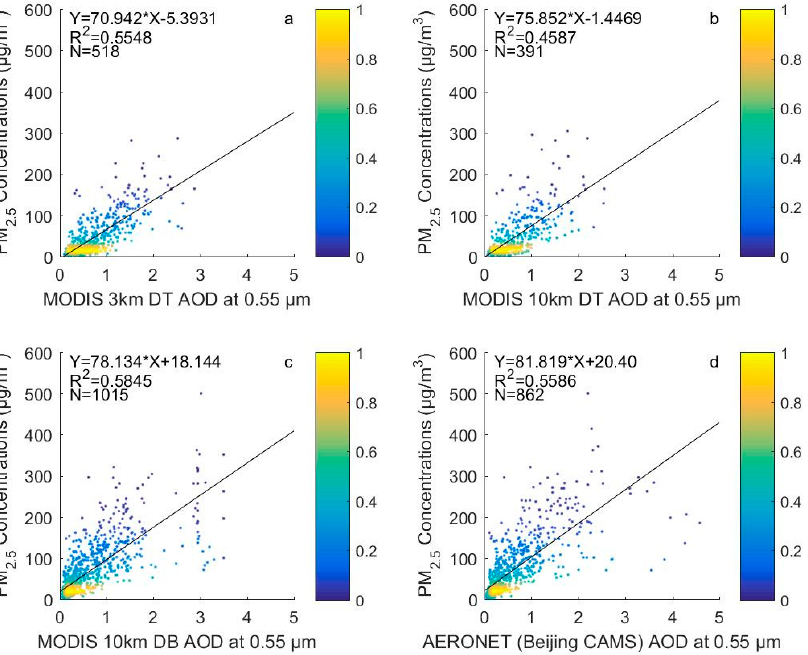
Figure 8. Correlation of PM 2.5 concentrations against the ( a ) MODIS 3 km DT AOD; ( b ) MODIS 10 km DT AOD; ( c ) MODIS 10 km DB AOD; and ( d ) AERONET AOD for the Beijing station.